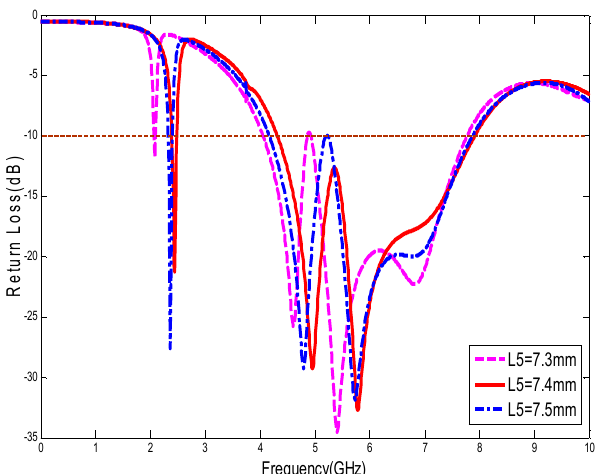
Figure 10. Simulated return loss versus frequency for the proposed antenna for various values of L 5 ; other parameters are the same as those listed in Table 2.